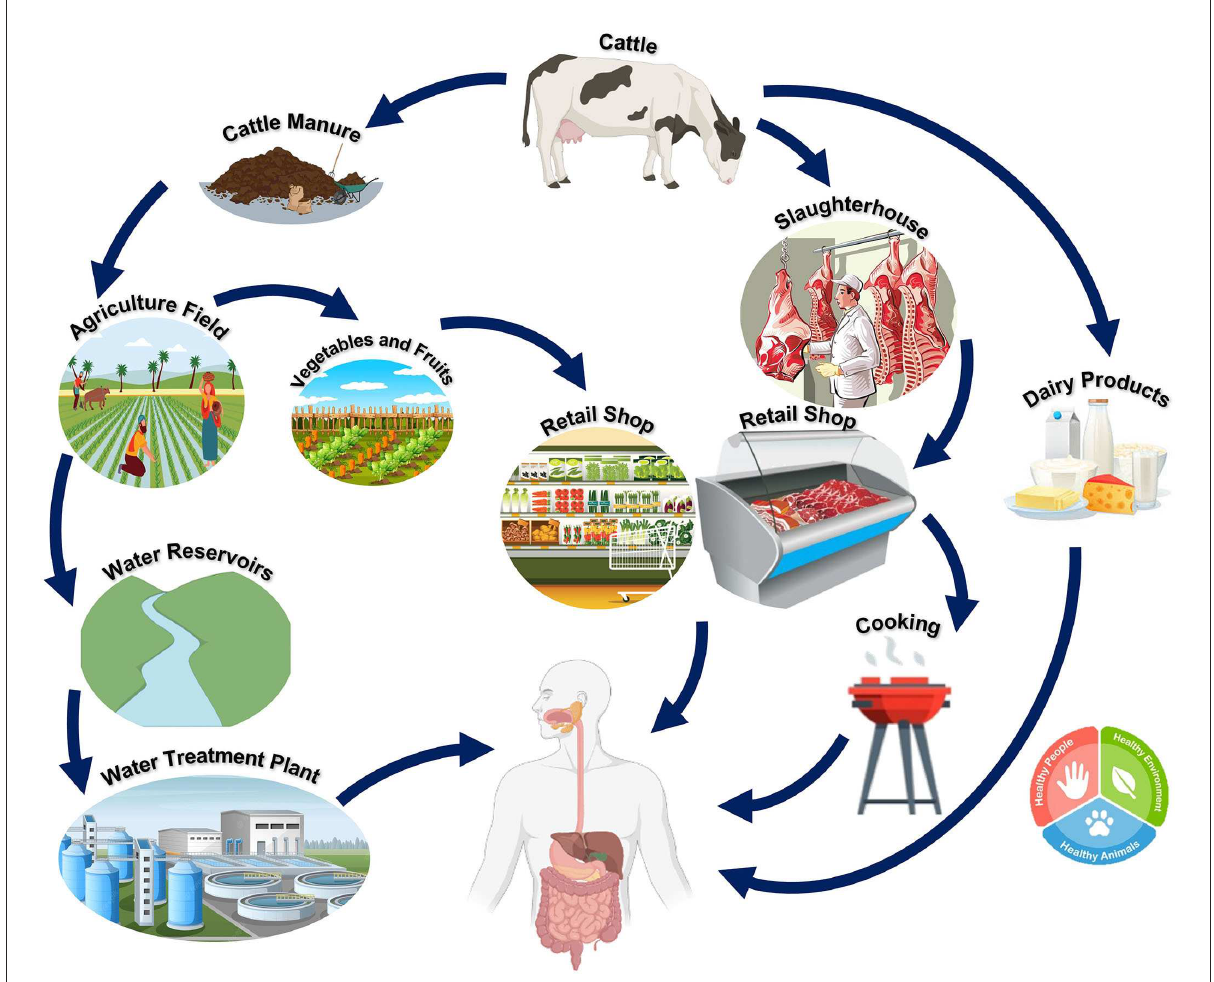
FIGURE4 Reservoir and transmission of E. coli O157:H7. Cattle act as the main reservoir for O157:H7. The pathogen can be transmitted from cattle to humans directly (through the contamination of meat, meat, or dairy products from cattle) or indirectly [adapted from Vidovic and Korber (21)].